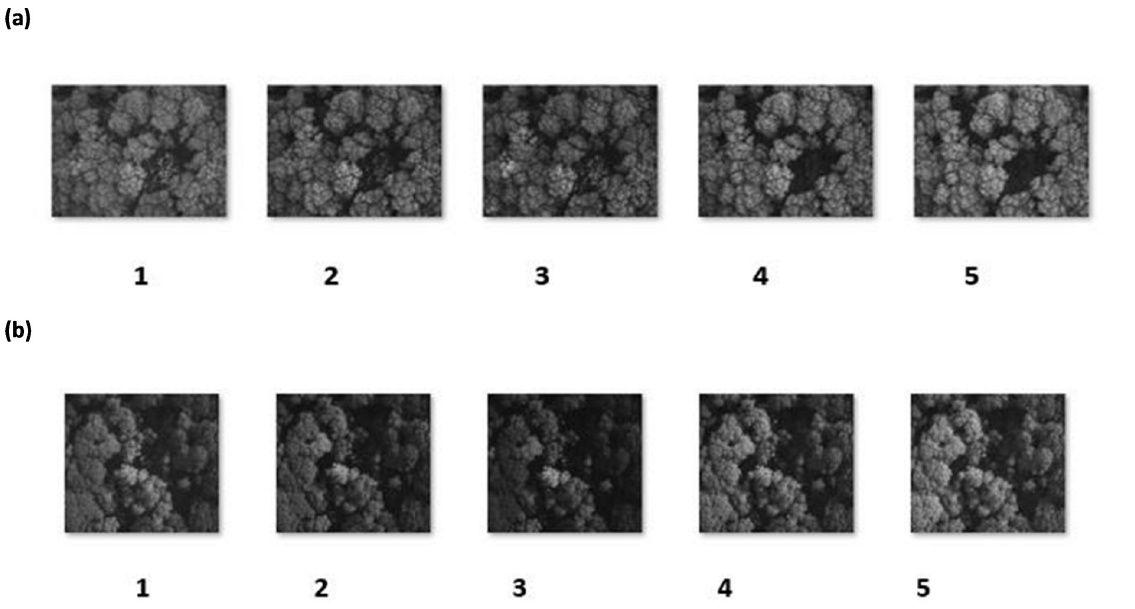
Fig 6. Multispectral images used from the central area of Priestclose Wood to perform PCA (a) multispectral image data set representing dead trees (b) multispectral image date set representing oak and silver birch trees. [1 = Blue, 2 = Green, 3 = Red, 4 = DR and 5 = NIR].